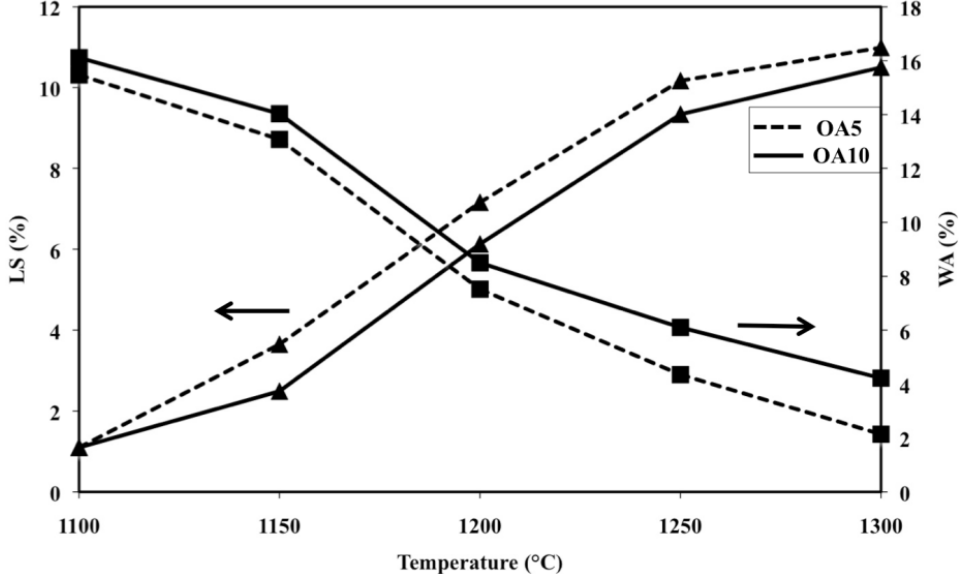
Figure 5. Linear shrinkage (LS) and water absorption (WA) as a function of firing temperature of samples OA5 and OA10 (LS: ▲; WA: ■